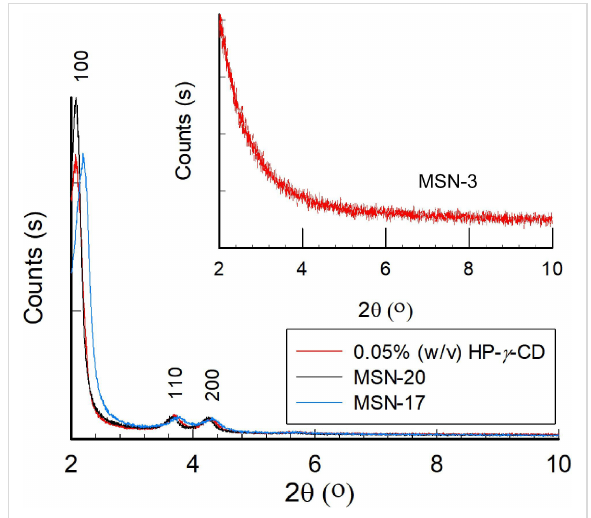
Figure 9: Wide-angle XRD patterns of the MSNs in the 2 θ range of 2–10°. MSN samples synthesized with HP- γ -CD (0.05% (w/v)) and β -CD (1% (w/v)) (MSN-17). Inset shows the XRD pattern of MSN-3.